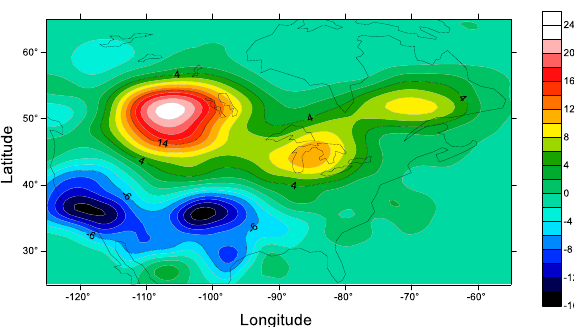
Figure 1. Trend rates of the separated TWS changes in North America (x10 -3 m